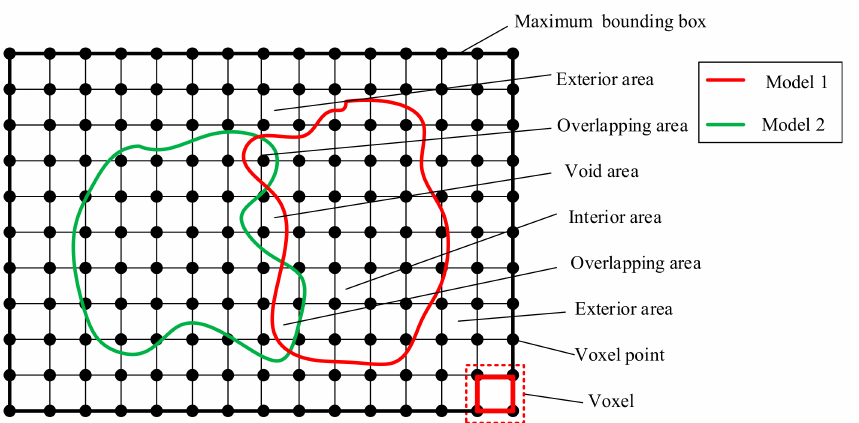
Figure 3. According to the inside and outside relationships of the models, it can be divided into internal and external areas, and according to the ambiguity, it can be divided into overlapping and void